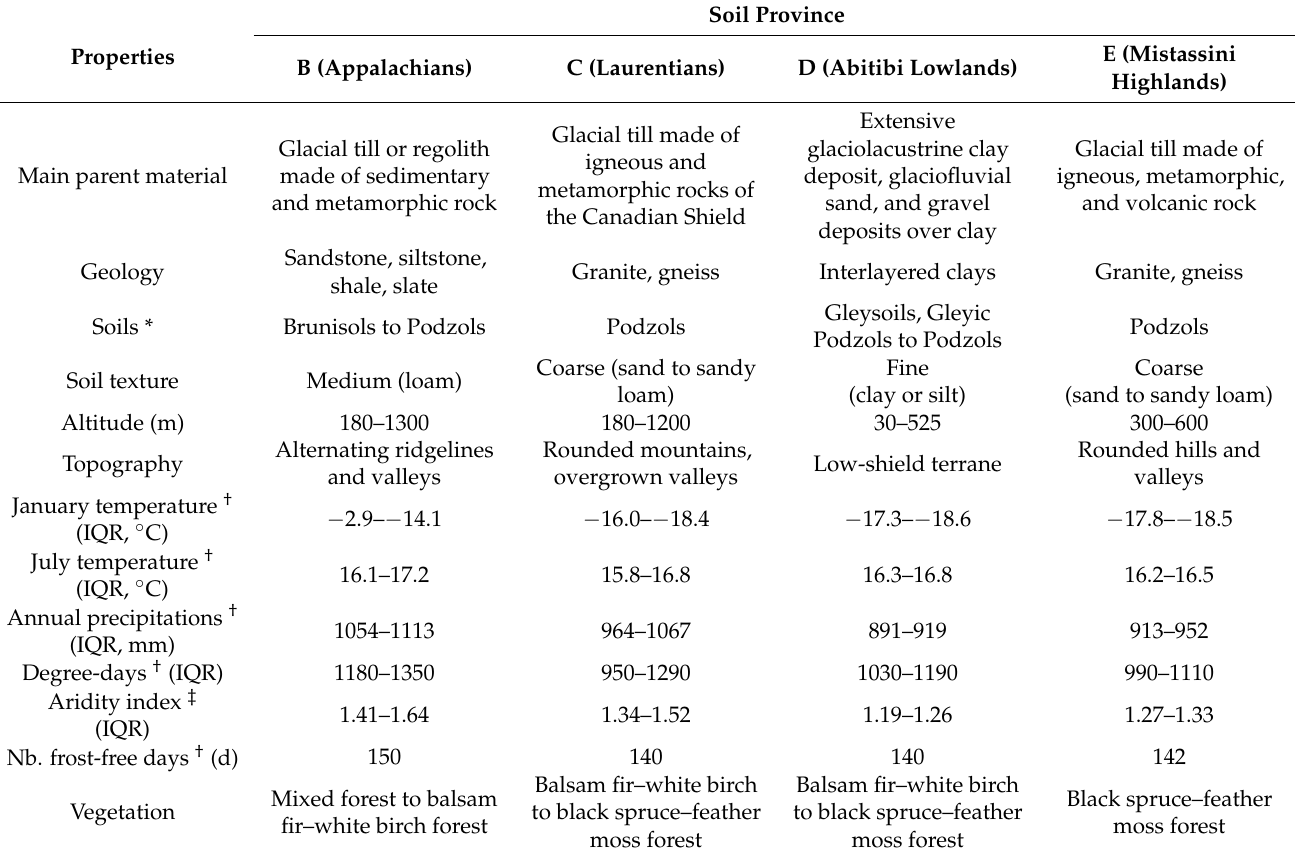
Table 1. Characteristics of the four soil provinces of Quebec included in the